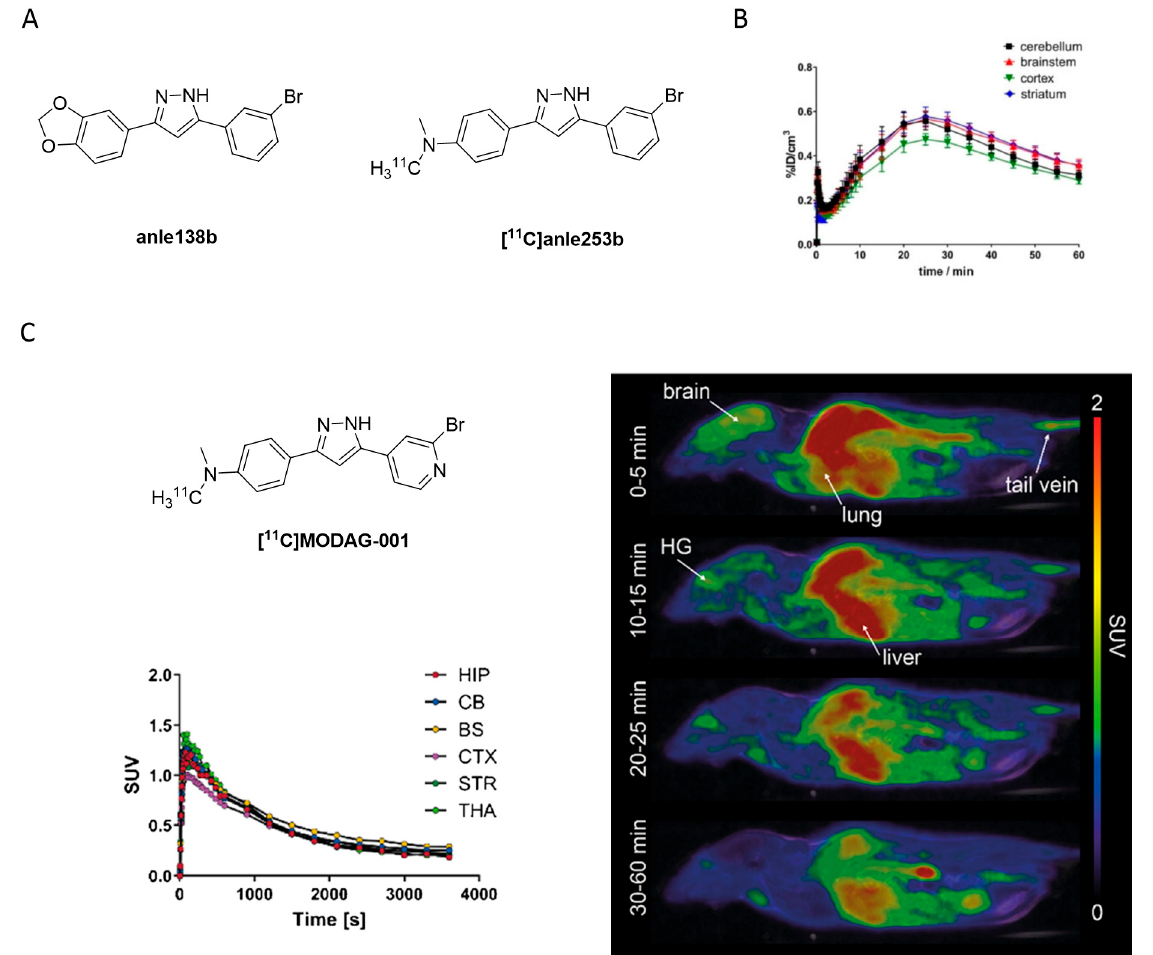
Figure 19. ( A ) Chemical structures of the 3,5-diphenylpyrazole derivatives anle138b and [ 11 C]anle253b . ( B ) TACs of the [ 11 C]anle253b obtained from the in vivo study in healthy rats (Adapted from [128]). ( C ) Chemical structure of the [ 11 C]MODAG-001 with TACs and PET images in mouse (Adapted from [129]).